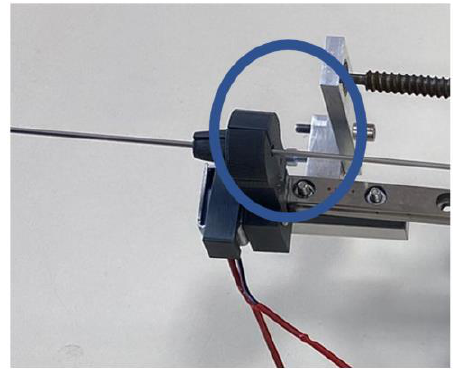
Figure 11. Needle centering device.